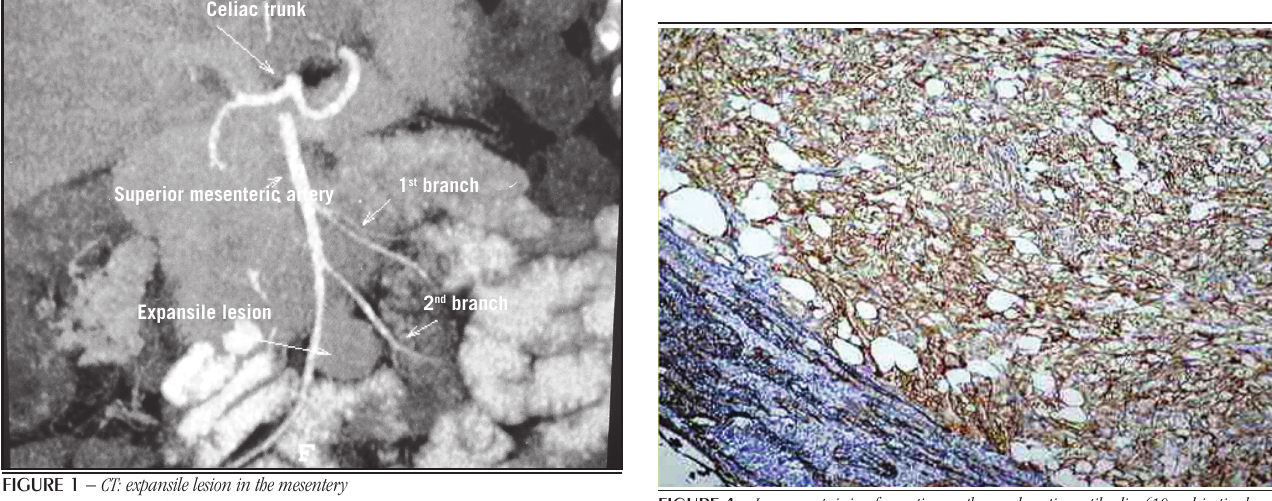
figurE 4 − Immunostaining for anti-smooth muscle actin antibodies (10× objective